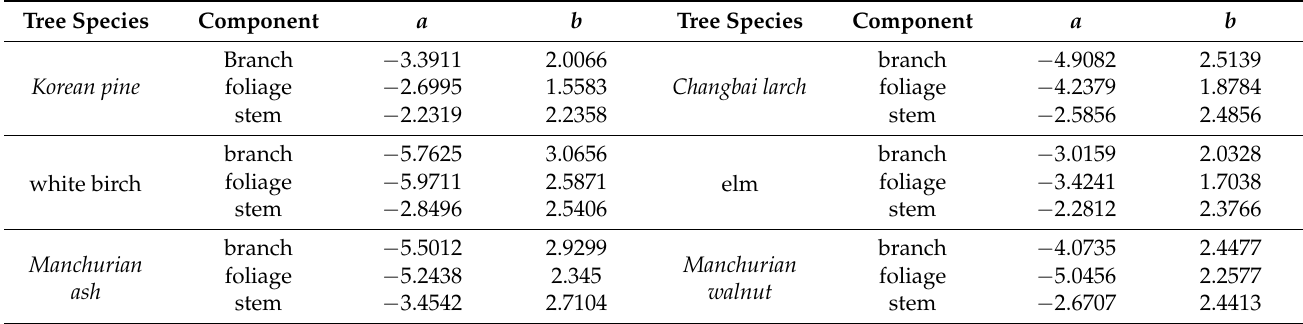
Table 3. The parameters of additive biomass equations for different tree species and components used in this study